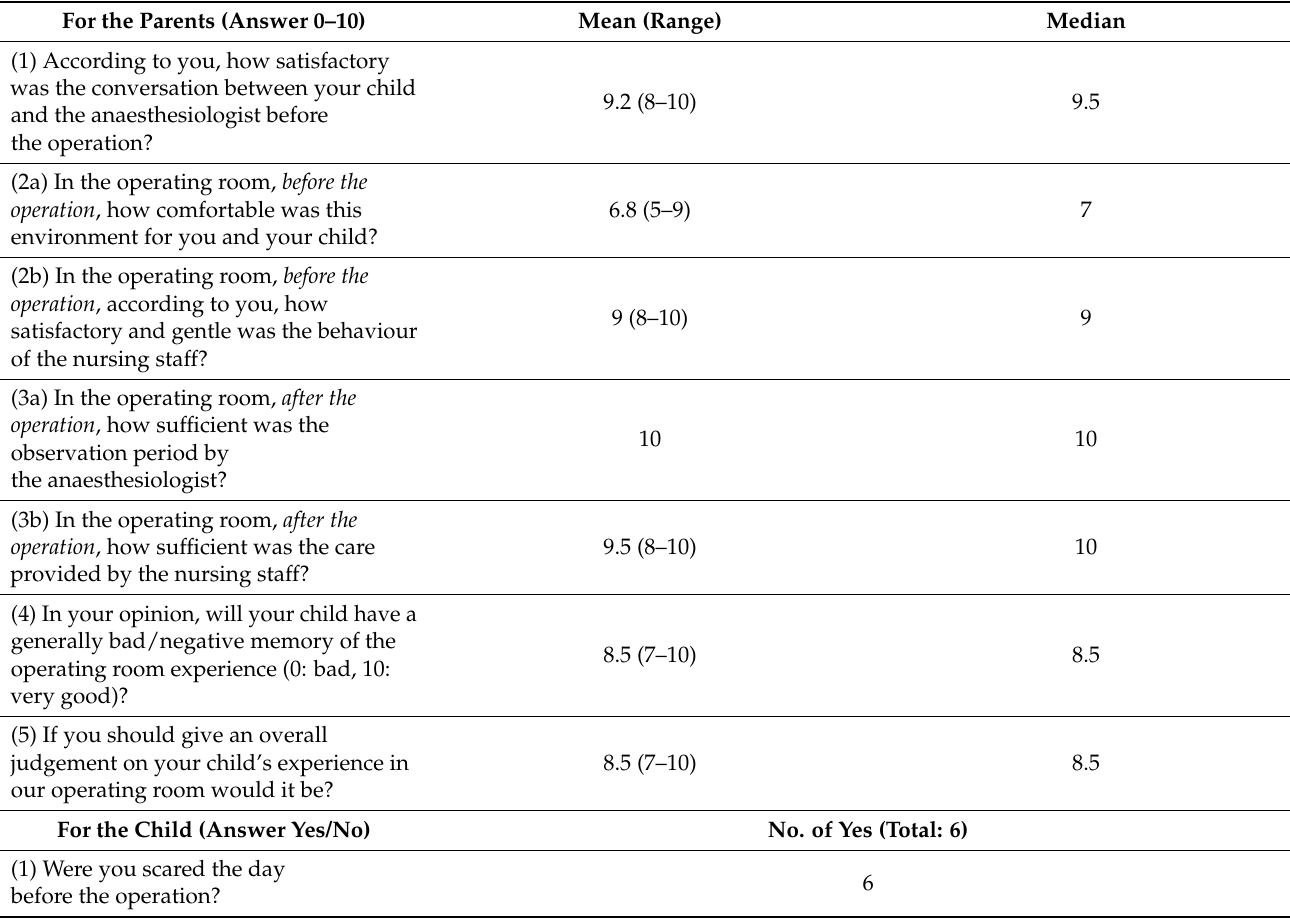
Table 3. Anaesthesiologic procedure evaluation according to Iacobucci et al.